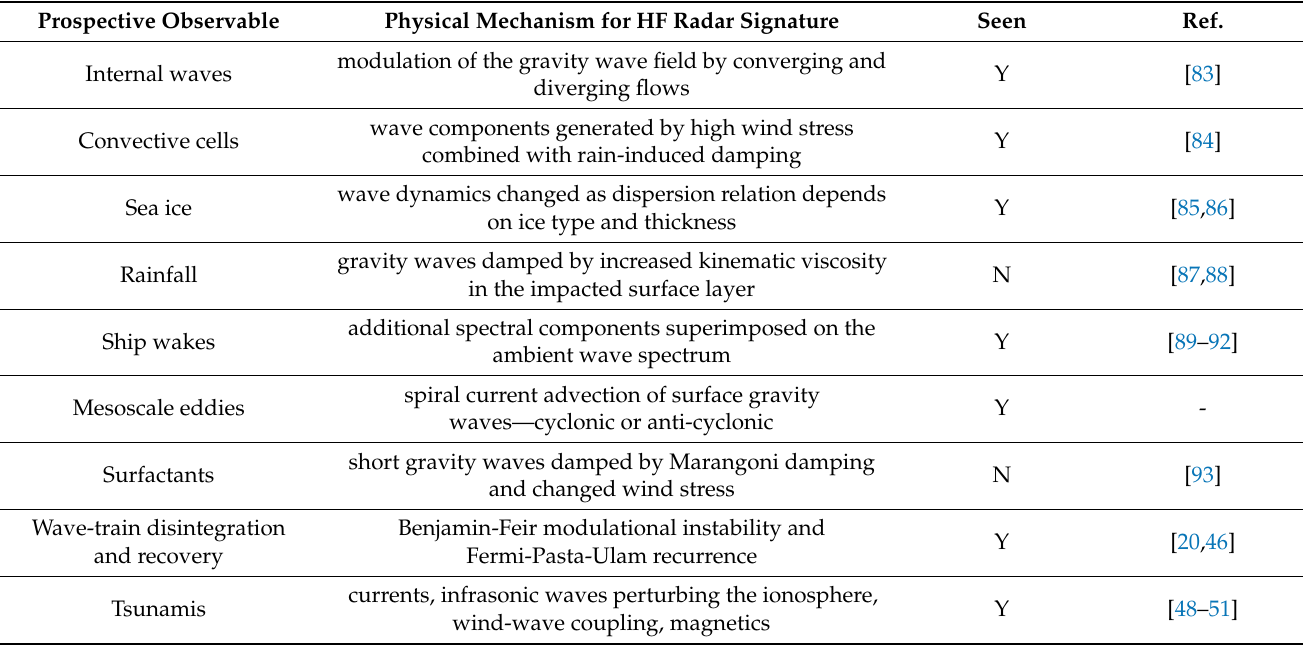
Table 1. Prospective observables and their signature